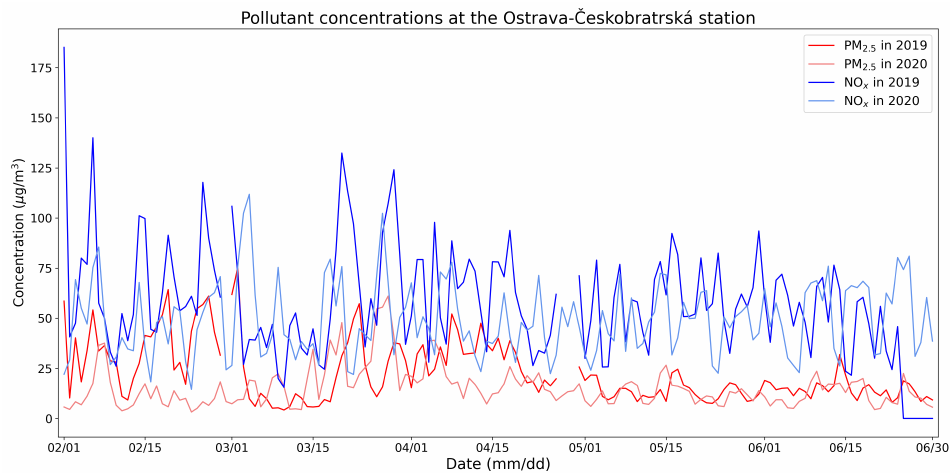
Figure A2. Daily average concentrations at the Ostrava- ˇCeskobratrská